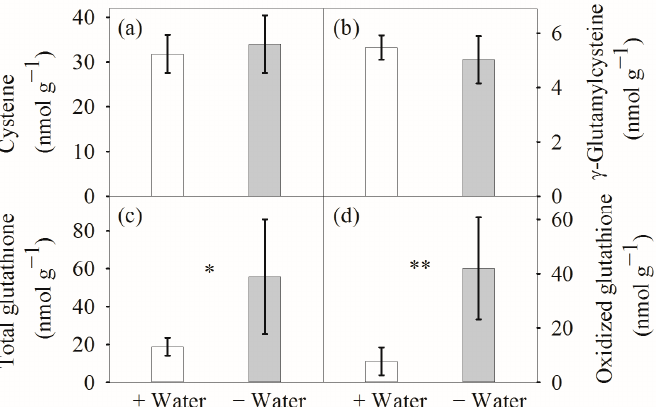
Figure 6. Thiols of cysteine ( a ), γ -glutamylcysteine ( b ), total ( c ), and oxidized glutathione ( d ) contents in leaves of Alnus glutinosa grown under sufficient (+ water, blank bars) and limited water conditions ( − water, grey bars). Data shown represent mean ± standard deviation ( n = 5) on a dry weight basis. Asterisks indicate significant differences between trees with sufficient and limited water supply at p < 0.05 (*) and 0.01 (**)